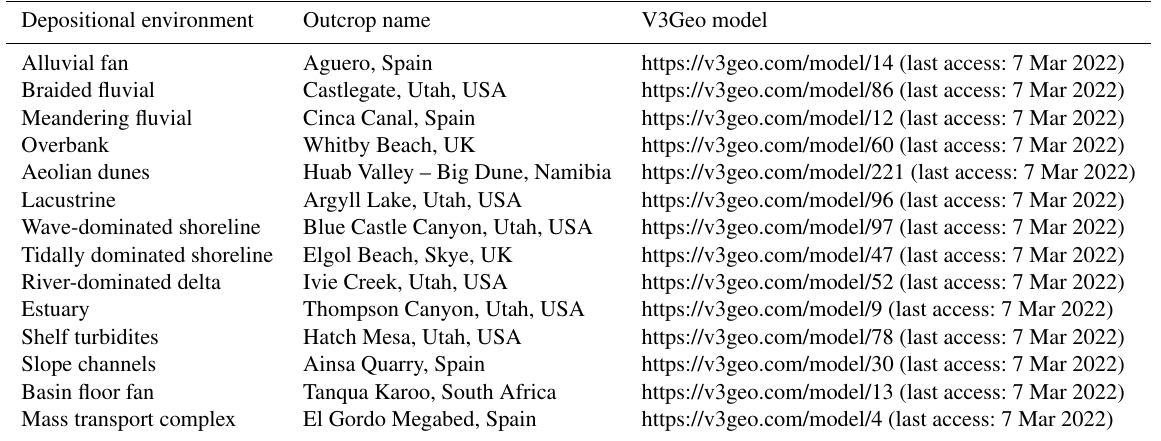
Table 2. V3Geo virtual outcrop models used for teaching sedimentary environments at